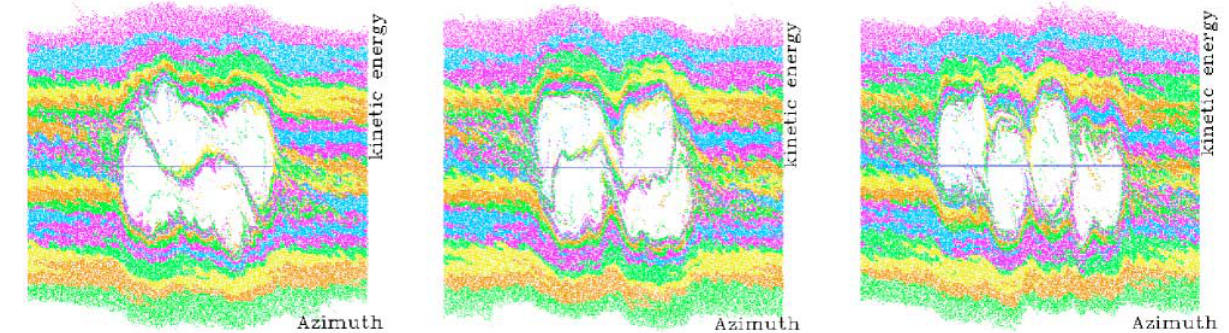
FIG. 32. (Color) Phase space scatter plots (left to right) at 2 13.99 , 2 13.87 , and 2 13.74 ms, respectively. 10 13 protons, 2.2 3 10 5 macroparticles.